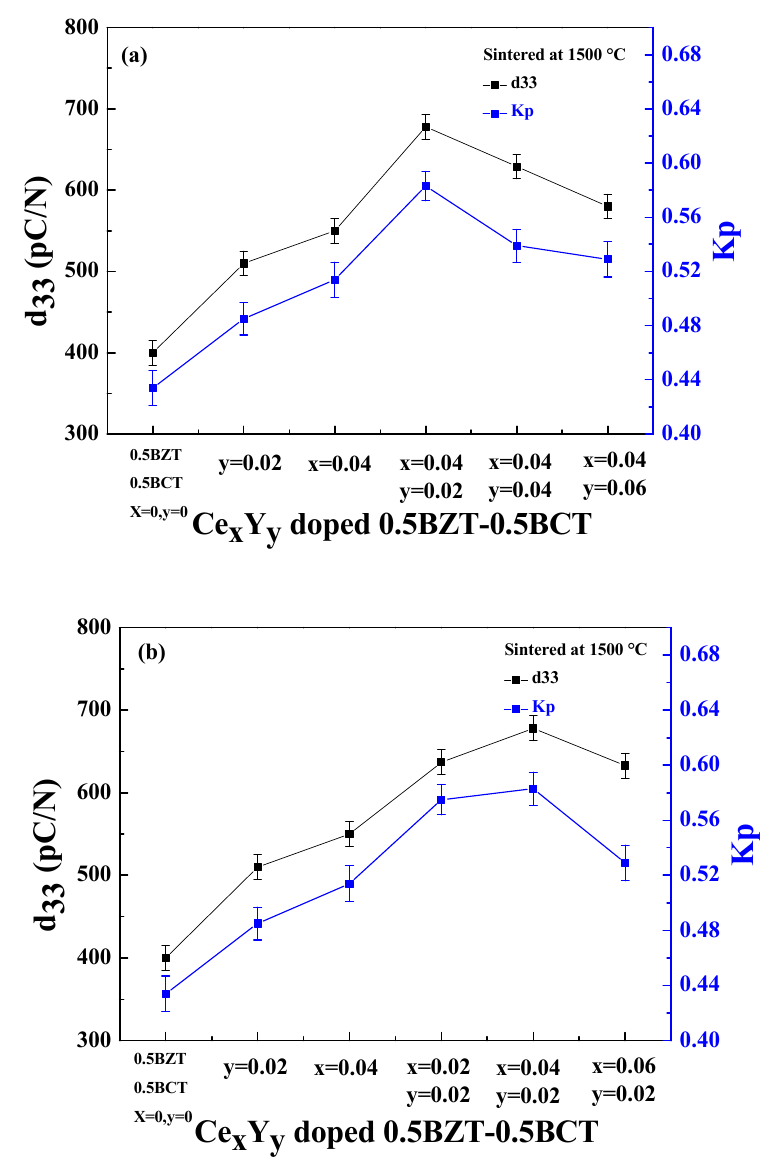
Figure 6. Display piezoelectric charge coefficient and electro-mechanical coupling coefficient of the Ce and Y doped BCZT ceramics. ( a ) For the Ce 0.04 Y y doped BCZT ceramics, ( b ) Ce x Y 0.02 doped BCZT ceramics, respectively.